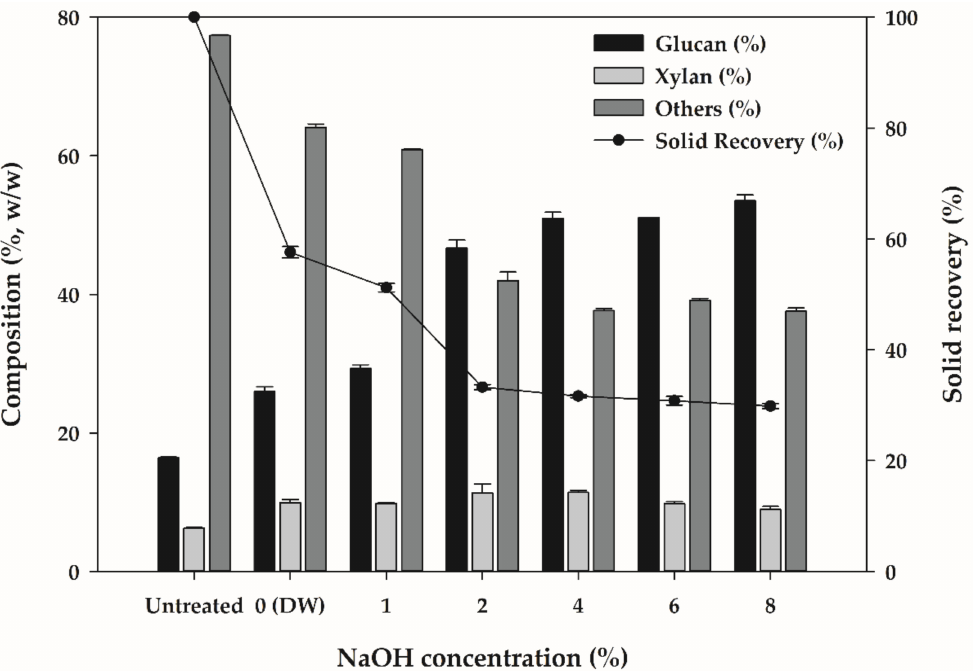
Figure 1. Chemical composition and solid recovery after pretreatment of Sicyos angulatus with different concentrations of NaOH at 121 ◦ C for 10